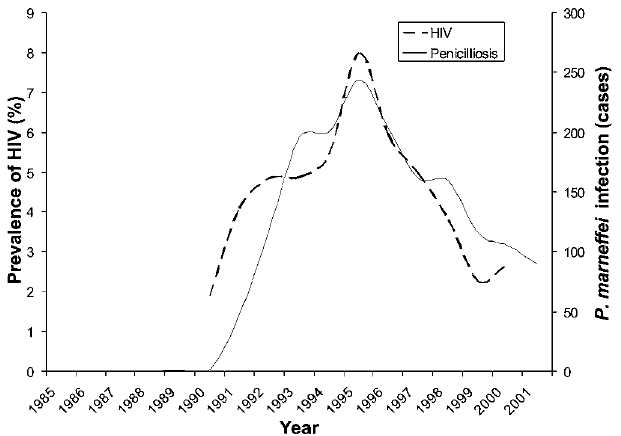
Figure 1. Co-Emergence of AIDS and Human Penicilliosis in Northern Thailand Temporal emergence of HIV (antenatal data, 1990–2000 [38]) and human P. marneffei –associated penicilliosis (1985–2001; Maharaj Hospital, Chiang Mai) for the Chiang Mai region, northern Thailand. DOI: 10.1371/journal.ppat.0010020.g001 PLoS Pathogens |